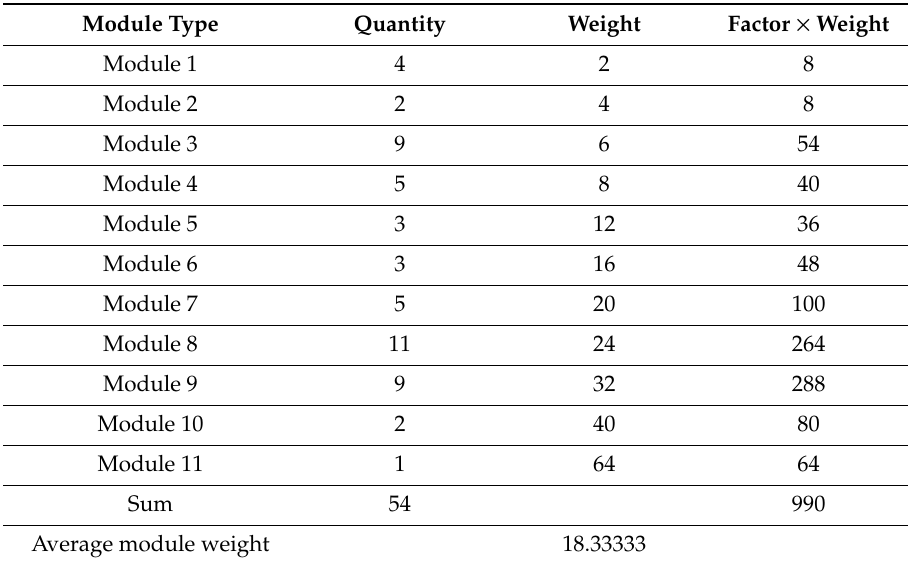
Table 3. Quantity and type of modules produced in the period